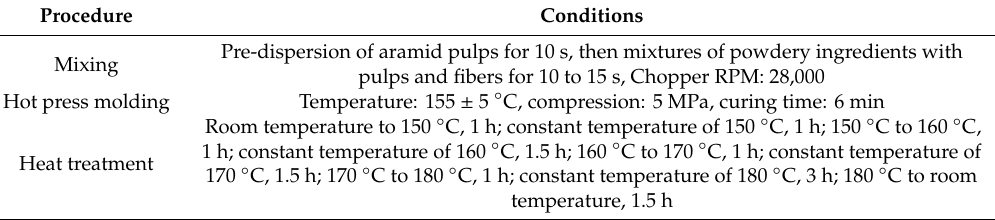
Table 2. Details of the processing conditions for composite